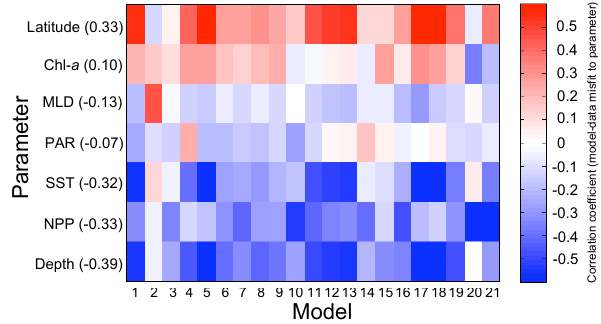
Fig. 7. Correlation between model-data misfit ( 1(i) ) and various parameters across all regions for individual models. Absolute val- ues of latitude were used. Values in parentheses are average corre- lation coefficients for each parameter across all